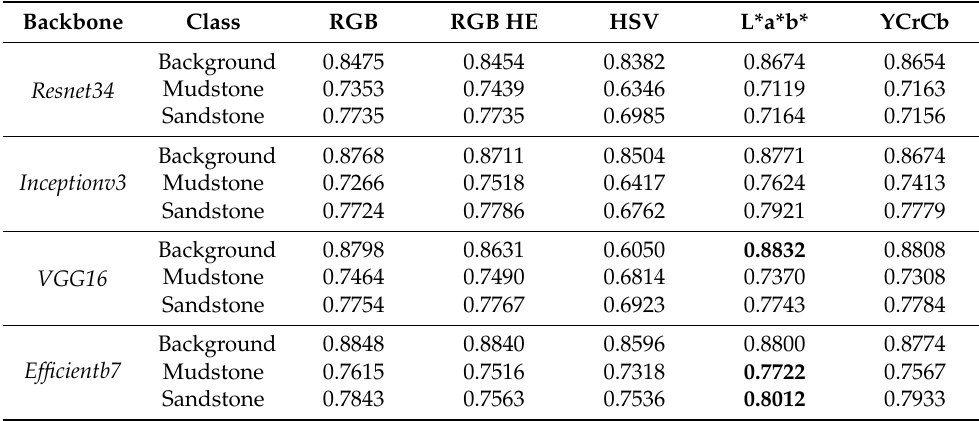
Table 4. Performance evaluation (IoU) of U-Net models for individual classes in test sets using different image color representations. The best model performance for each class is presented in